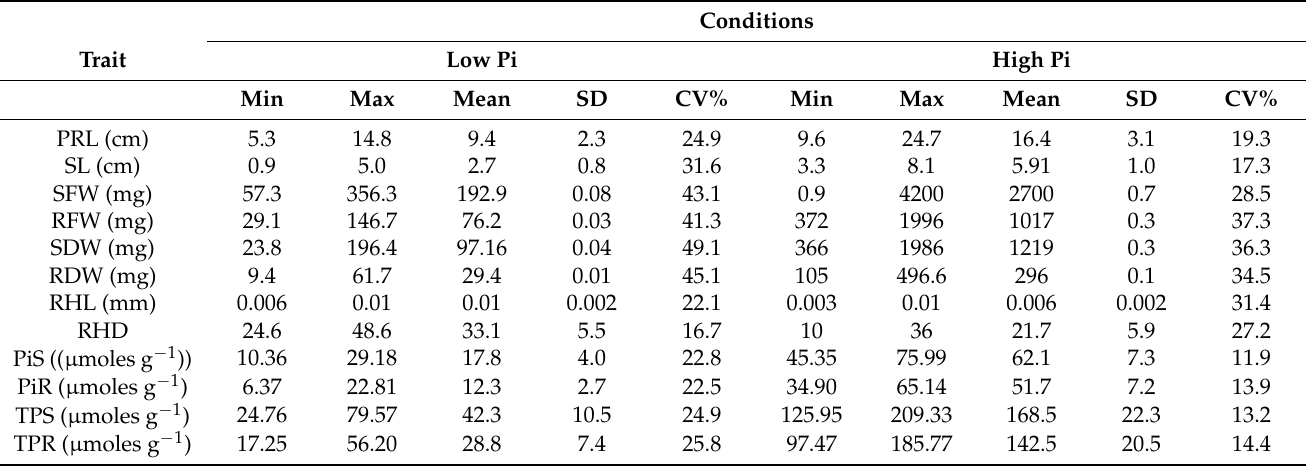
Table 1. Mean performances of agro-morphological and P-content-related traits of 100 F 2 : 3 RILs of finger millet grown under LP and HP